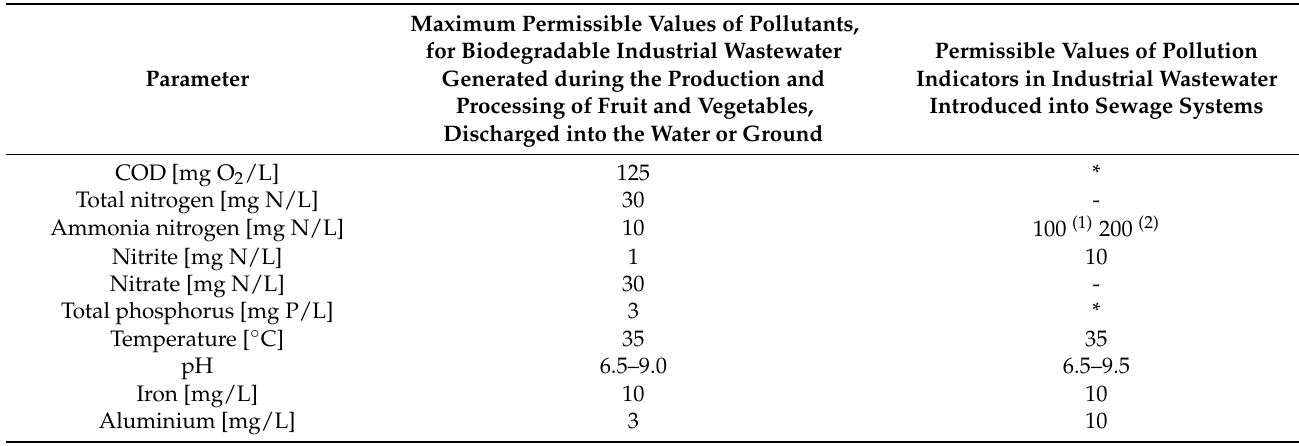
Table 1. The EU regulations for wastewater discharged into natural waters and the ground and Polish regulations regarding industrial wastewater discharged into municipal sewage